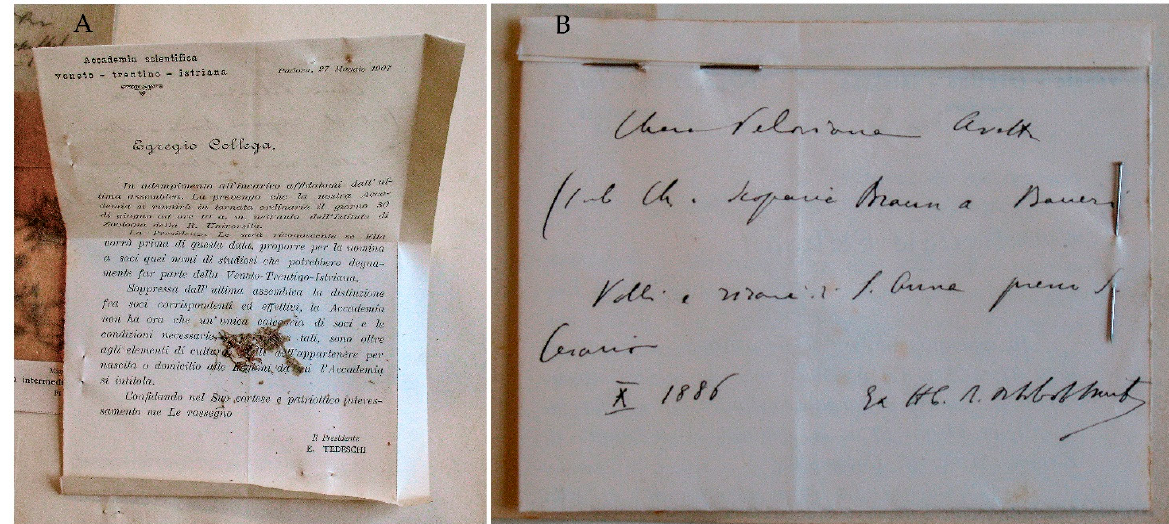
Figure 6. ( A ) PAD portion of Chara pelosiana removed from MOD specimen. ( B ) Béguinot’s indications on the envelope.